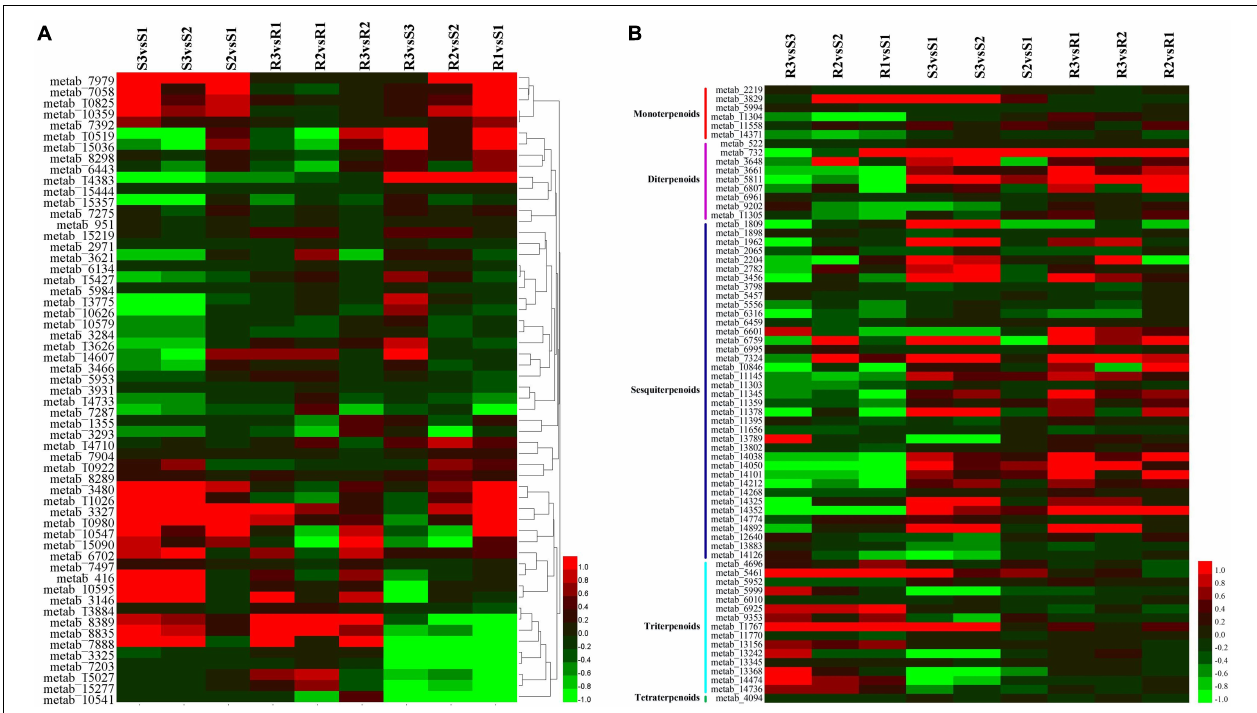
FIGURE 6 | Expression patterns of (A) phenylpropanoids biosynthesis- and (B) terpenoids-related metabolites. Each row represents a metabolite, while each column represents metabolite comparisons. For example, the S3vsS1 column means the log 2 (S3/S1). The heatmap was developed via HemI toolkit using log 2 fold change (log 2 FC) values (Deng et al.,